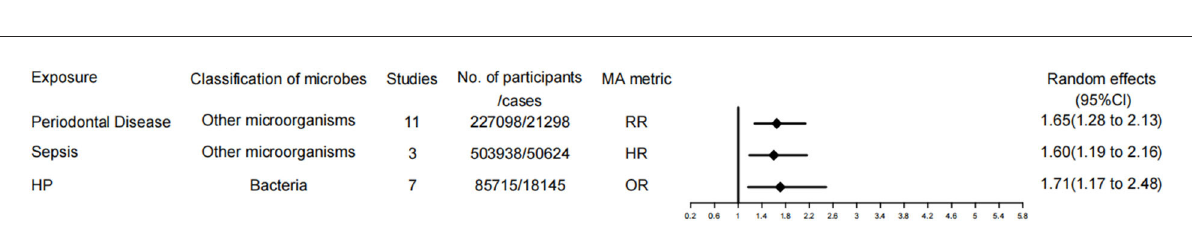
FIGURE4 Forest plots and the level of evidence of the association of microbiological factors with dementia. HP, Helicobacter pylori